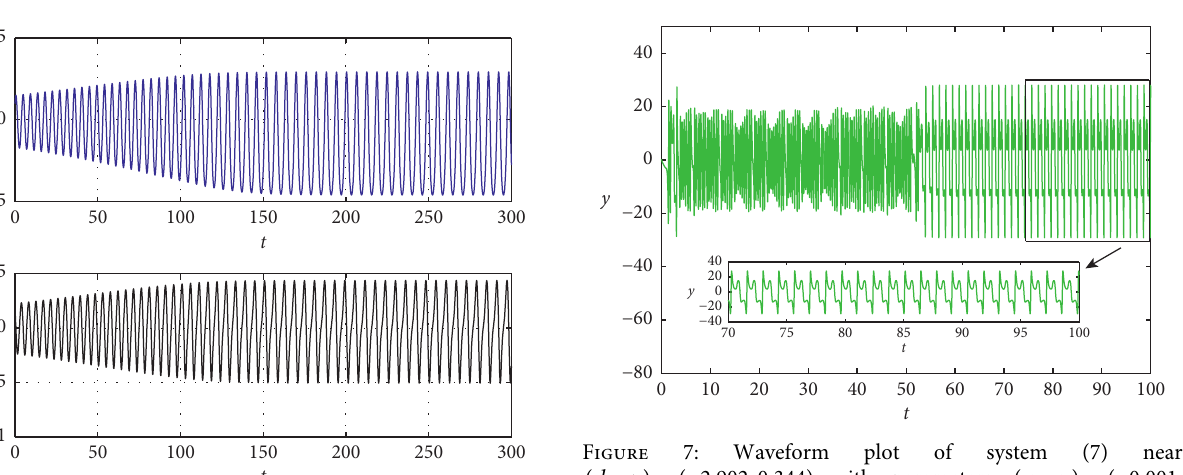
, μ ) � (− 0 . 001 , 1 2 ,y ) � ( 0 . 1 , 0 . 2 ) 0 0